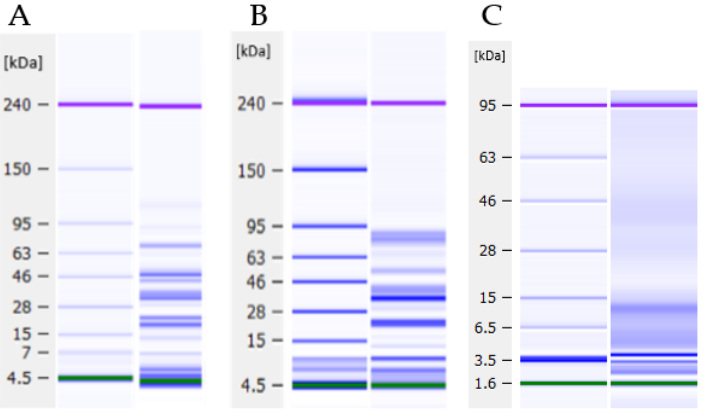
Figure 1. Protein profiles for pea ( A ), soy ( B ) and EverPro ( C ), as analysed using the Bioanalyzer under reducing conditions.